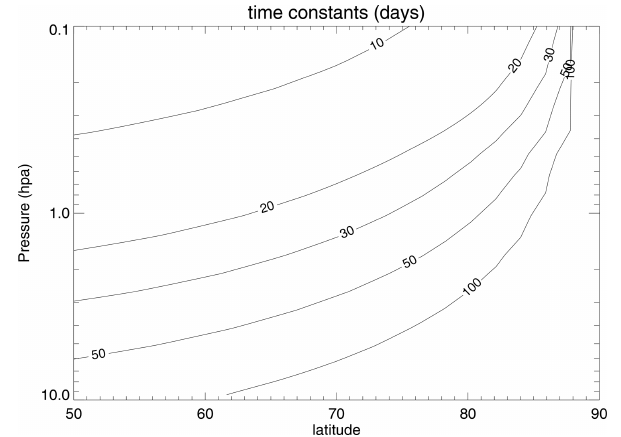
Figure 15. Diurnally averaged time constant against NO photoly- sis by UV sunlight as a function of latitude and pressure. Equinox conditions are